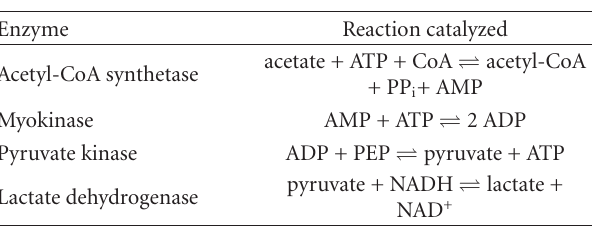
Table 2: Activity measurement of the acetyl-CoA synthetase via auxiliary enzymes. The decrease of the absorption of NADH was tracked photometrically at 340